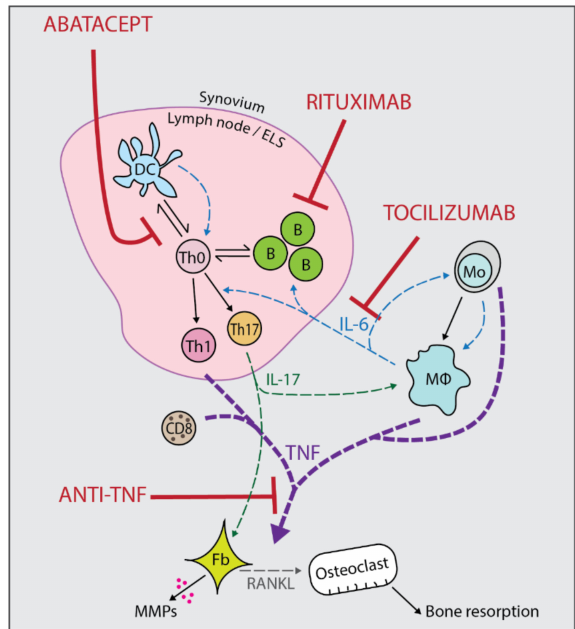
Figure 1. Sites of action of the main biologic drugs used in rheumatoid arthritis (RA). The cartoon represents the synovial membrane compartment with an associated ectopic lymphoid structure. Cytokine pathways are shown by dashed arrow lines. Abatacept works by blocking co-stimulation between DCs and T cells. Rituximab depletes B cells which may present antigen to T cells and produce autoantibodies. Tocilizumab blocks the actions of IL-6 which has many pro-inflammatory e ff ects within the synovium. Anti-TNF blocks the actions of TNF which is able to activate fibroblasts and osteoclasts resulting in joint damage. B: B cell, CD8: Cytotoxic T cell, DC: Dendritic cell, ELS: Ectopic lymphoid structure, Fb: Fibroblast, M Φ : Macrophage, Mo: Monocyte, T: T cell, Th0: Naïve T helper cell, Th1: